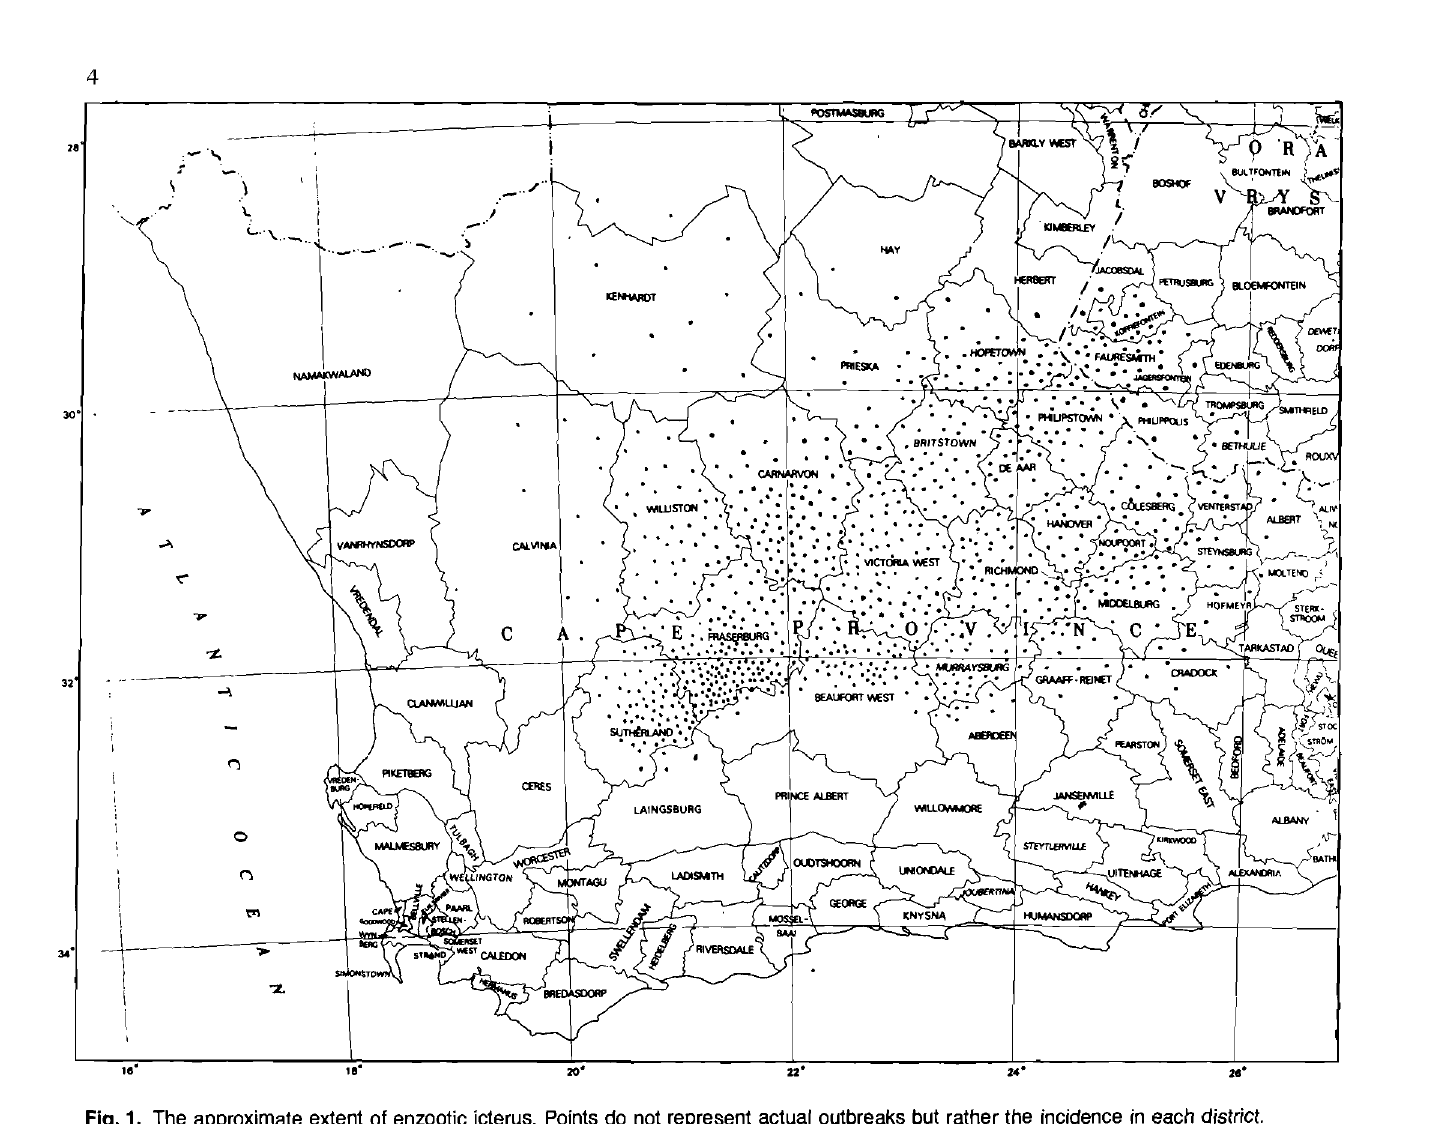
Fig, 1, The approximate extent of enzootic icterus. Points do not represent actual outbreaks but rather the incidence in each